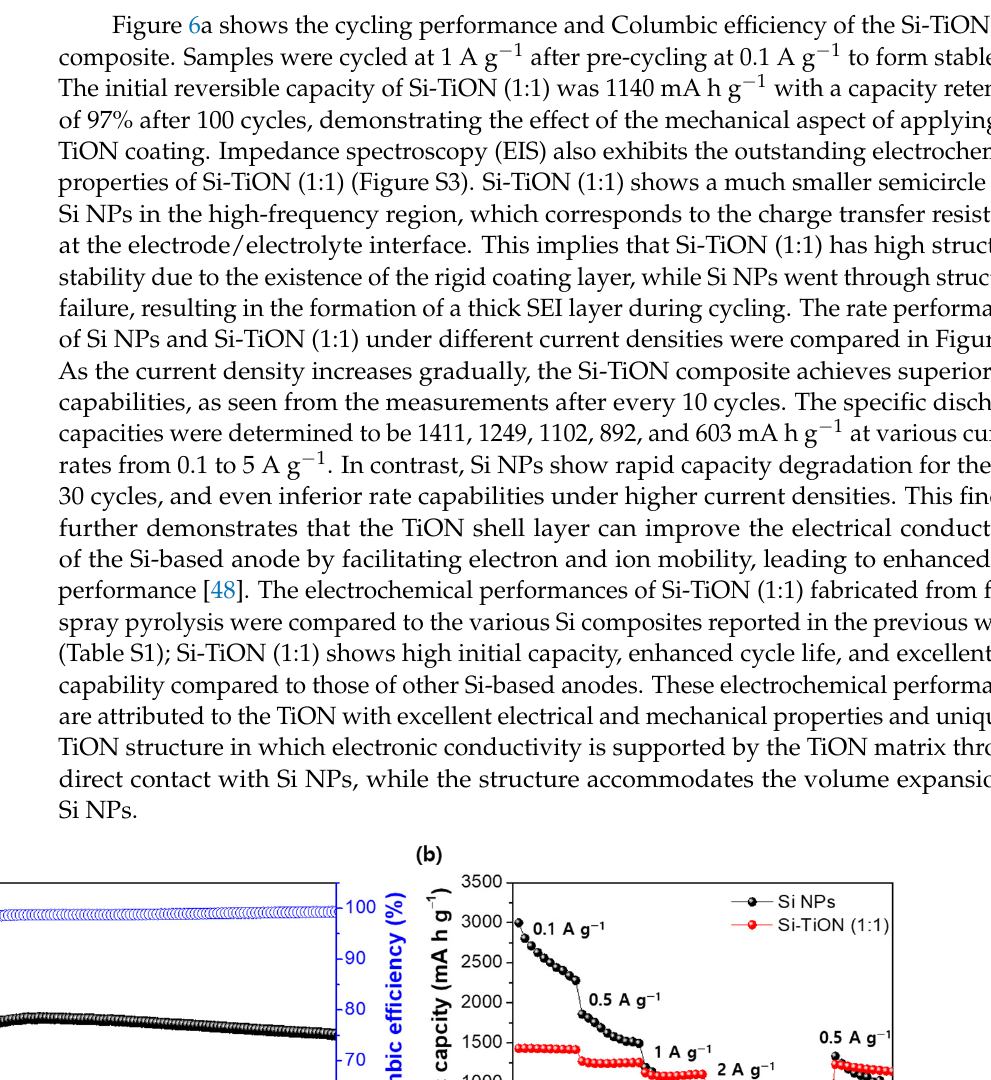
Figure 5. Voltage profiles for first and selected subsequent cycles at 0.1 A g –1 and 2 A g –1 , respec- tively: ( a ) Si NPs, ( b ) Si-TiON (1:0.5), and ( c ) Si-TiON (1:1).